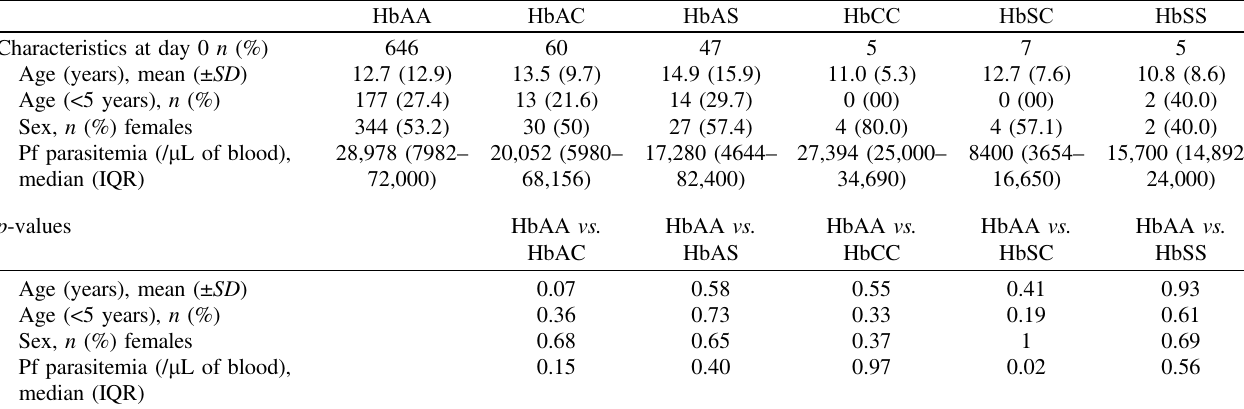
Table 1. Baseline demographic